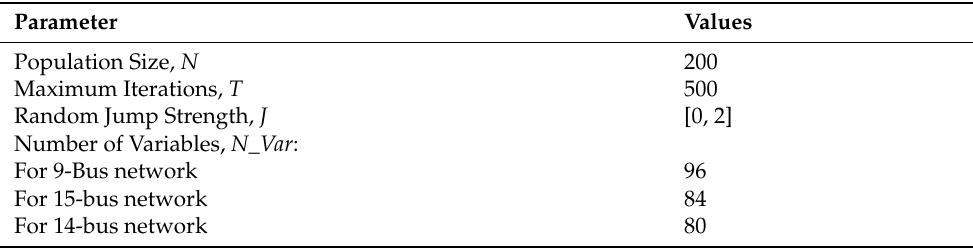
Table 1. HHO parameters used during the